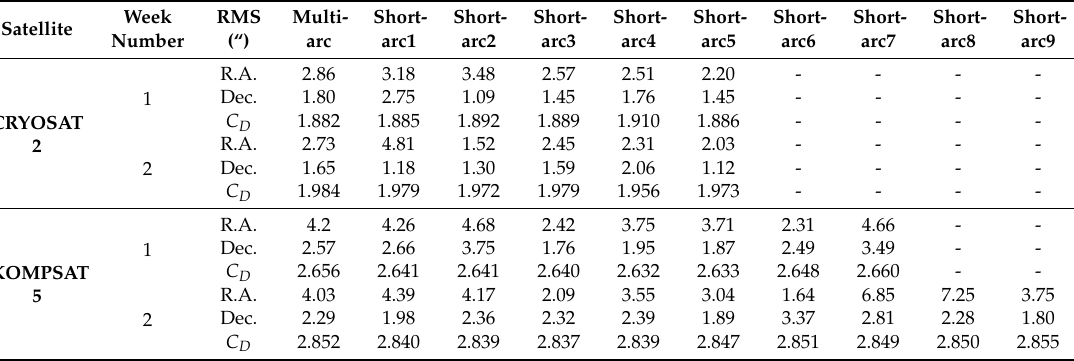
Table 4. Post-fit residuals (Root-Mean-Square (RMS), arc seconds) of multi-arc and short-arc batch least-squares (BLS) orbit estimation results for CRYOSAT 2 and KOMPSAT 5 (right ascension (R.A.), declination (Dec.)). The short-arc BLS orbit estimation results were similar to the multi-arc BLS orbit estimation results. The estimated atmospheric drag coefficients ( C D ) for multi-arc and short-arc BLS orbit estimations for CRYOSAT 2 and KOMPSAT 5 are described.